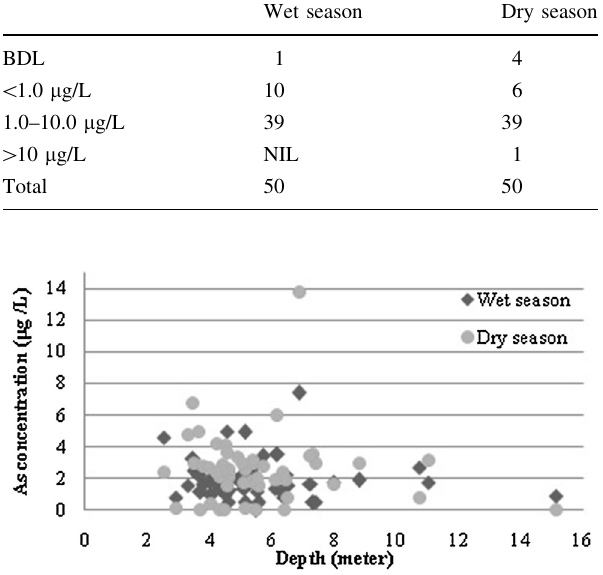
Fig. 5 Depth wise distribution of Arsenic in the shallow aquifers